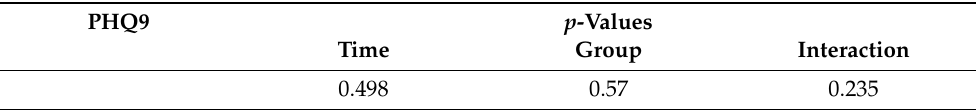
Table 5. Mixed ANOVA results examining changes in mood from baseline to completion be- tween groups. PHQ9 p -Values